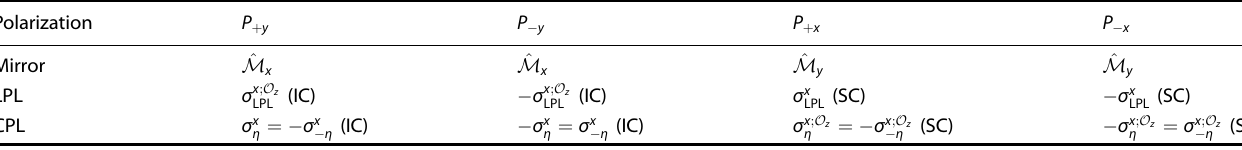
Table 1. Polarization dependent bulk (charge, spin, and orbital) photovoltaic conductivities.